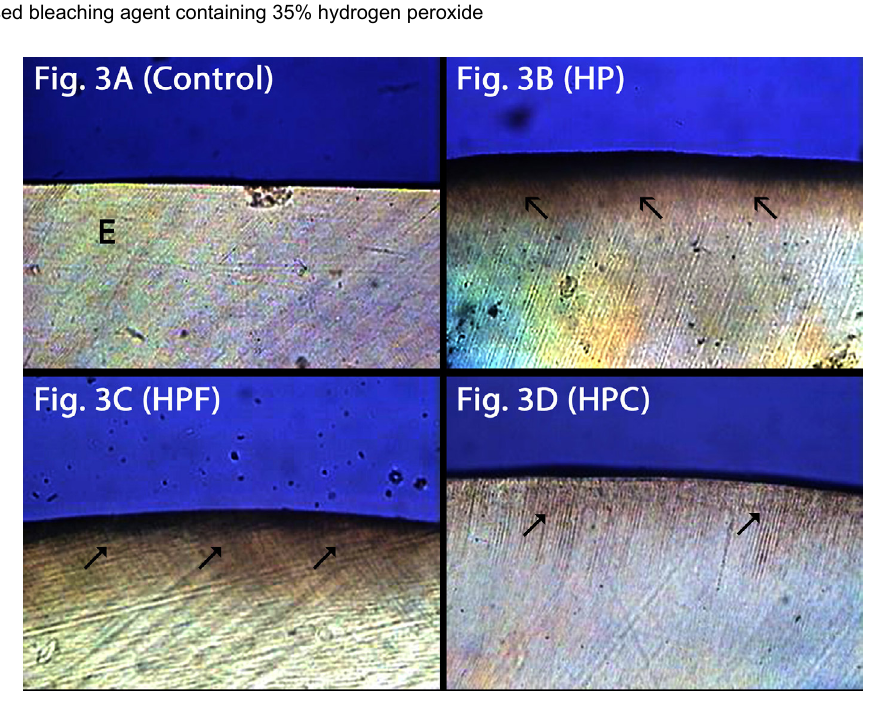
Figure 3- Sound enamel through polarized light microscopy. 3A: Control group with sound surface; 3B: HP group with slightly demineralized area on the surface; 3C: (HPF) minor subsurface demineralization similar to Figure 3D (HPC). (E: enamel; black arrows: demineralized